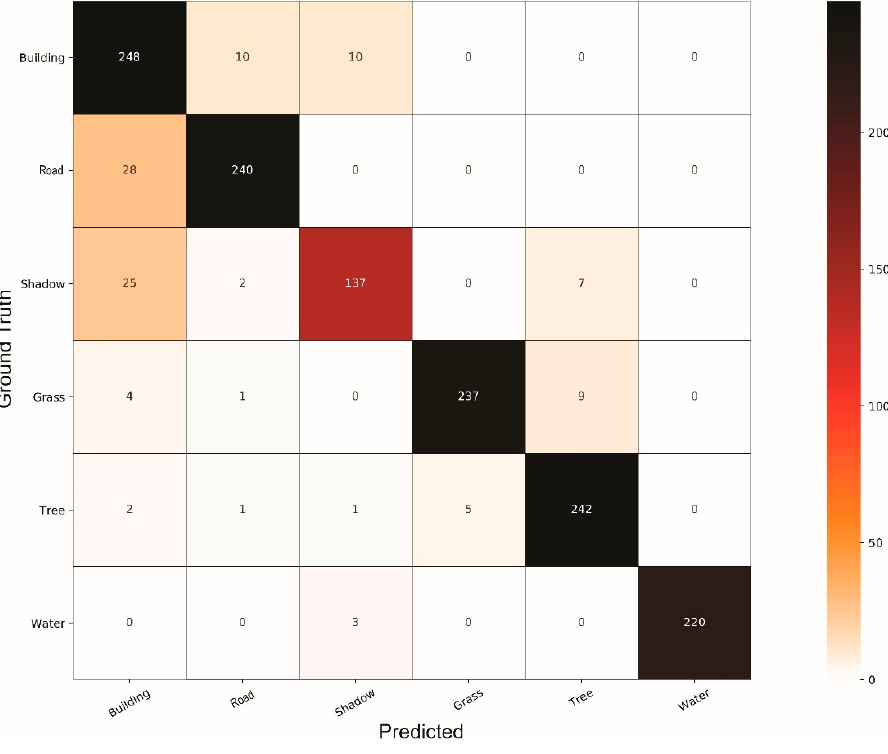
Figure A10. Confusion matrix of the SVM model for 50 cm image.